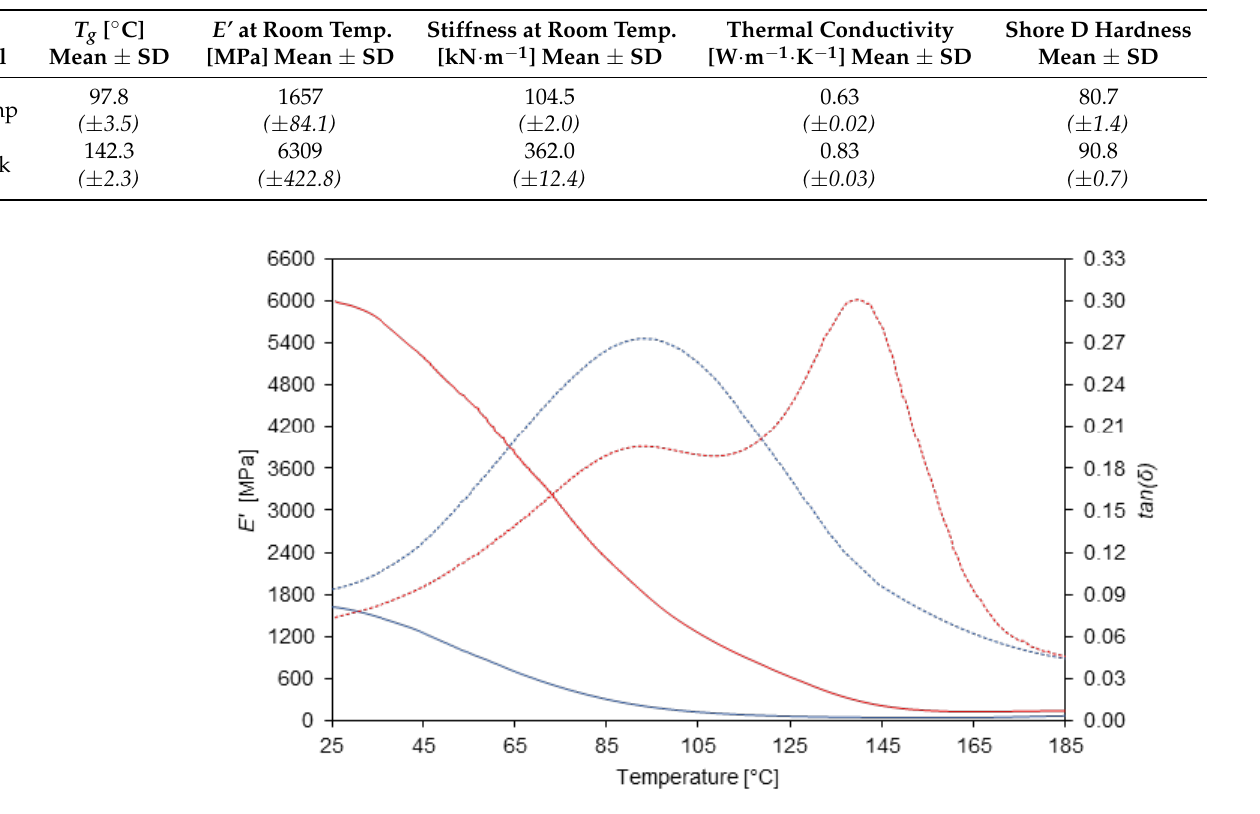
Figure 6. Storage modulus (continuous line) and tan( δ ) (dashed line) for HighTemp (blue) and Rigid 10k (red) insert materials.